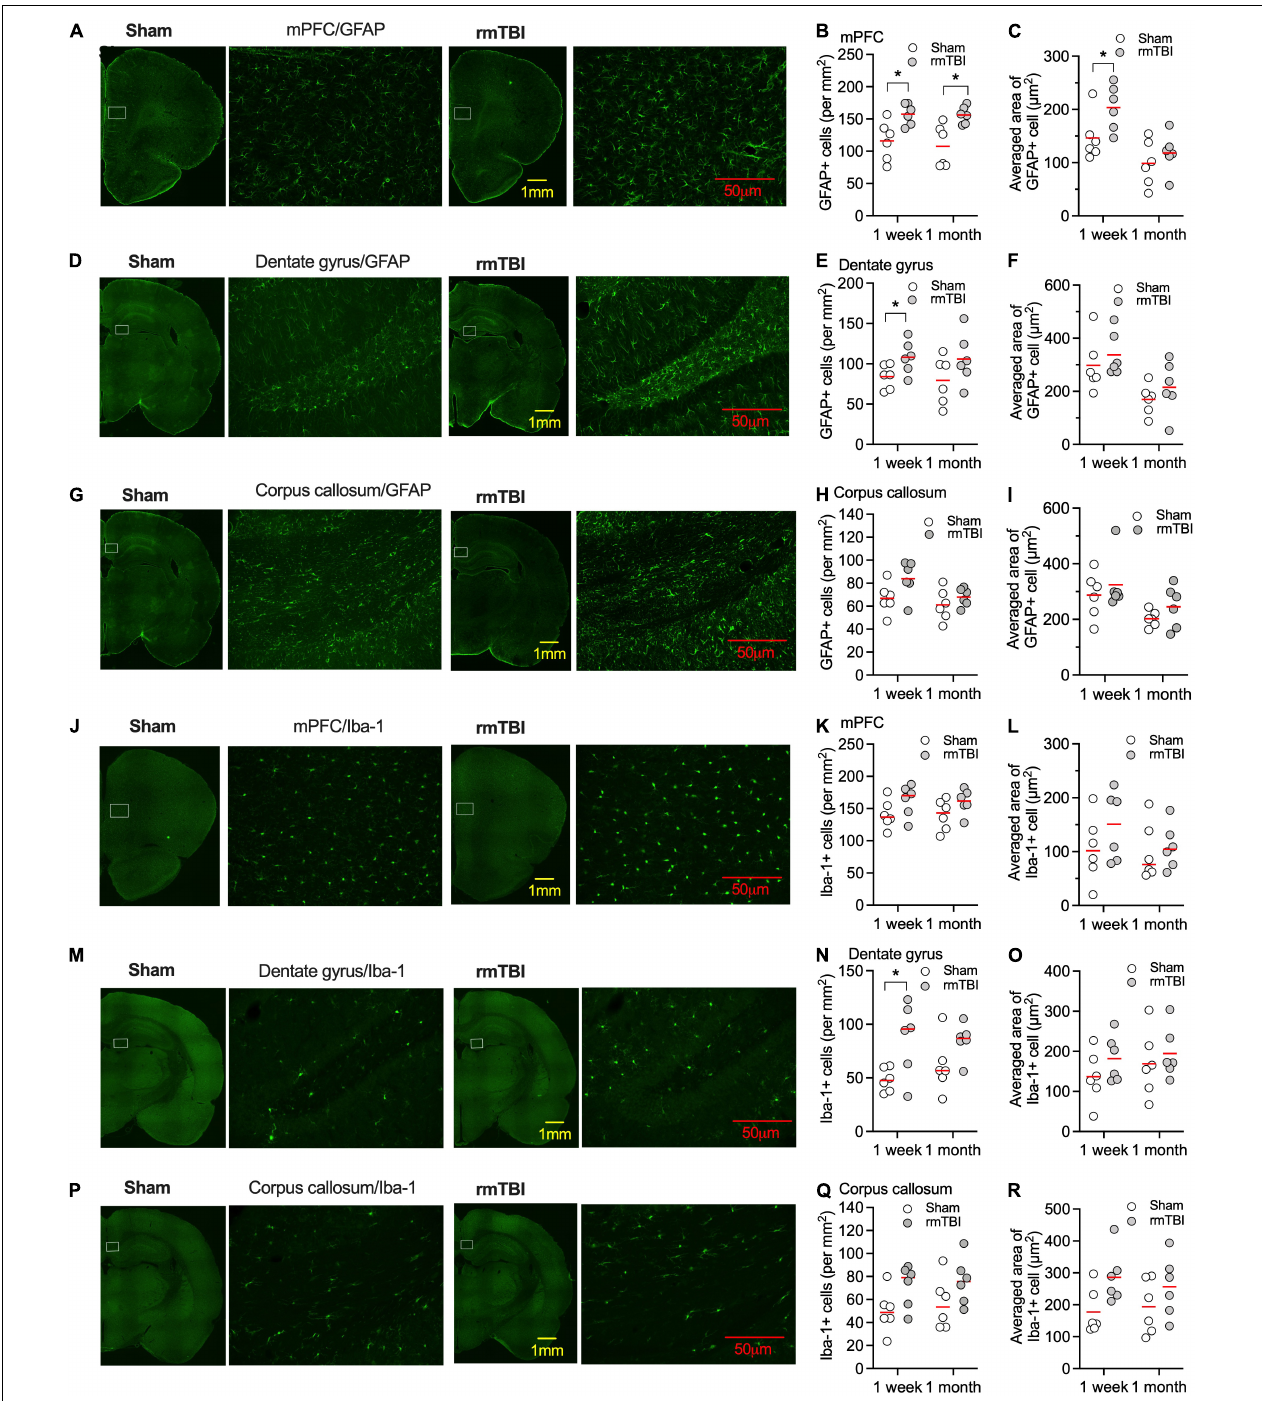
FIGURE 5 | Expression of GFAP and Iba-1 after rmTBI. In mPFC, there are increased number of GFAP+ cells 1 week and 1 month after rmTBI in mPFC (A,B) . (C) There are increased averaged area of GFAP+ cells 1 week after rmTBI in mPFC. There are increased number of GFAP+ cells 1 week after rmTBI in dentate gyrus (D,E) , but not in averaged area of GFAP+ cells (F) . (G–I) No differences in number of GFAP+ cells and averaged area of GFAP+ cells are found from injury in corpus callosum. (J–L) No differences of number of Iba-1+ cells and averaged area of Iba-1+ cells are found from injury in mPFC. (M–O) There are increased number of Iba-1+ cells 1 week after rmTBI in dentate gyrus and no differences of averaged area of Iba-1+ cells are found from injury in dentate gyrus. (P–R) No differences in number of Iba-1+ cells and averaged area of Iba-1+ cells are found from injury in corpus callosum. White rectangles in images with low power objective magnification represent areas for the images with high power objective magnification on their right side. Each dot represents averaged expression from 3 brain slice sections from each rat. Red bars represent mean. * P < 0.05 by planned comparison with Bonferroni correction.